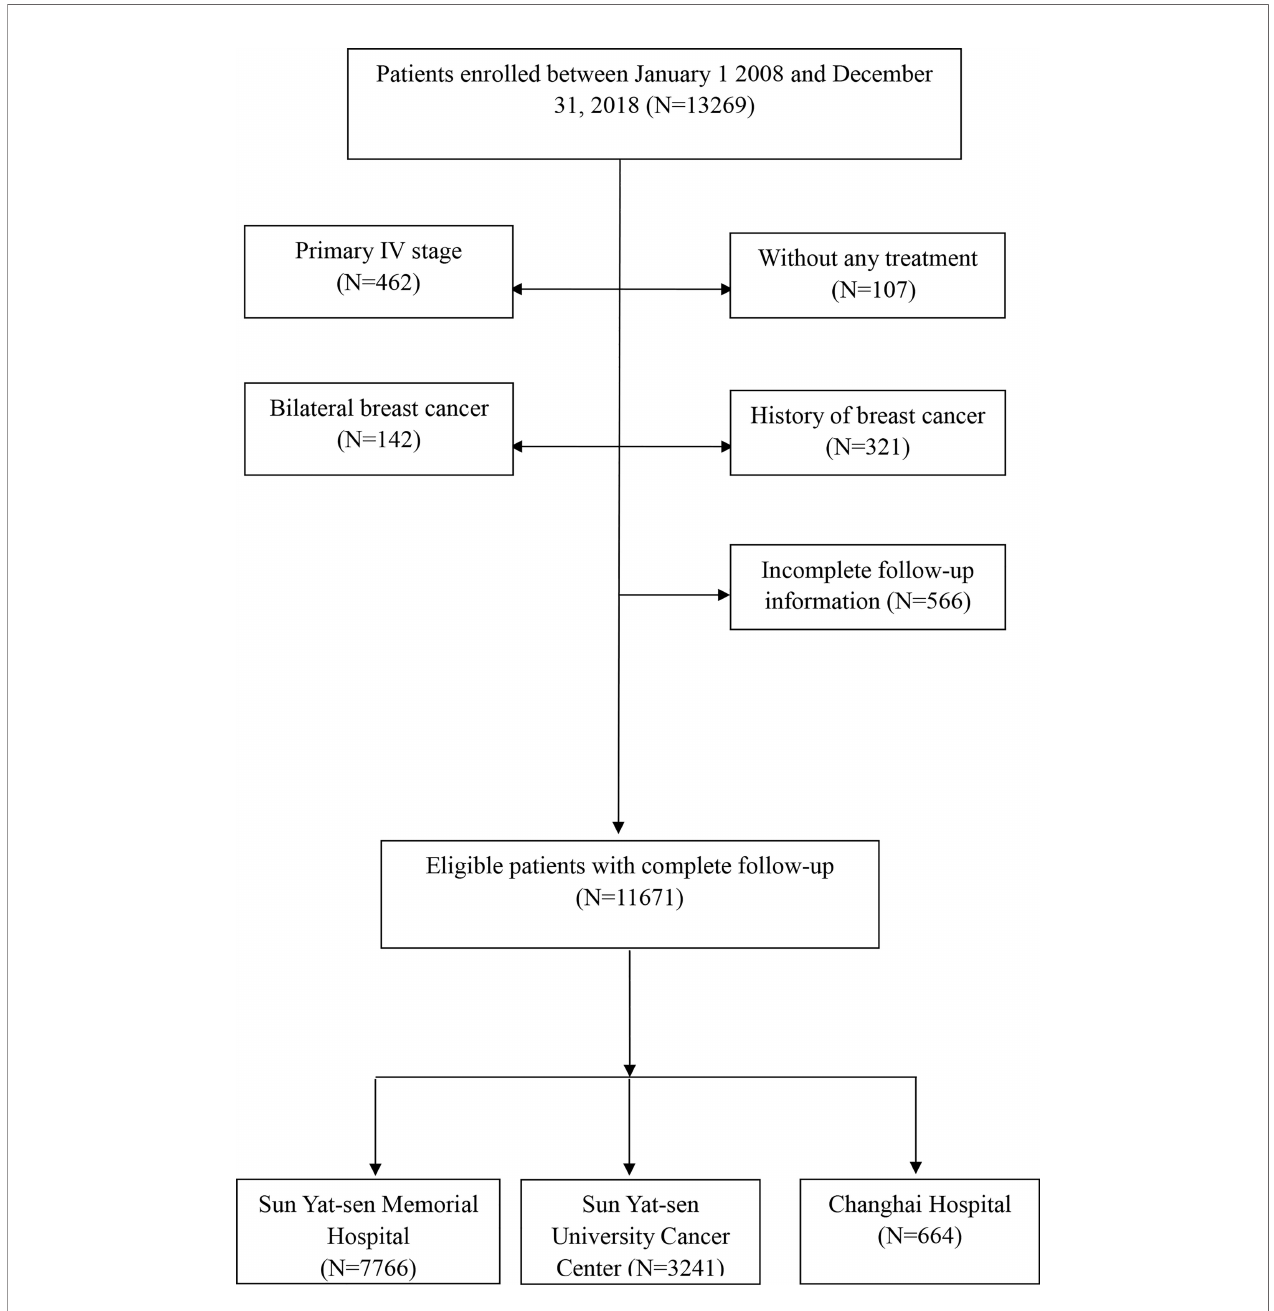
FIGURE 1 | Flowchart of enrollment in the